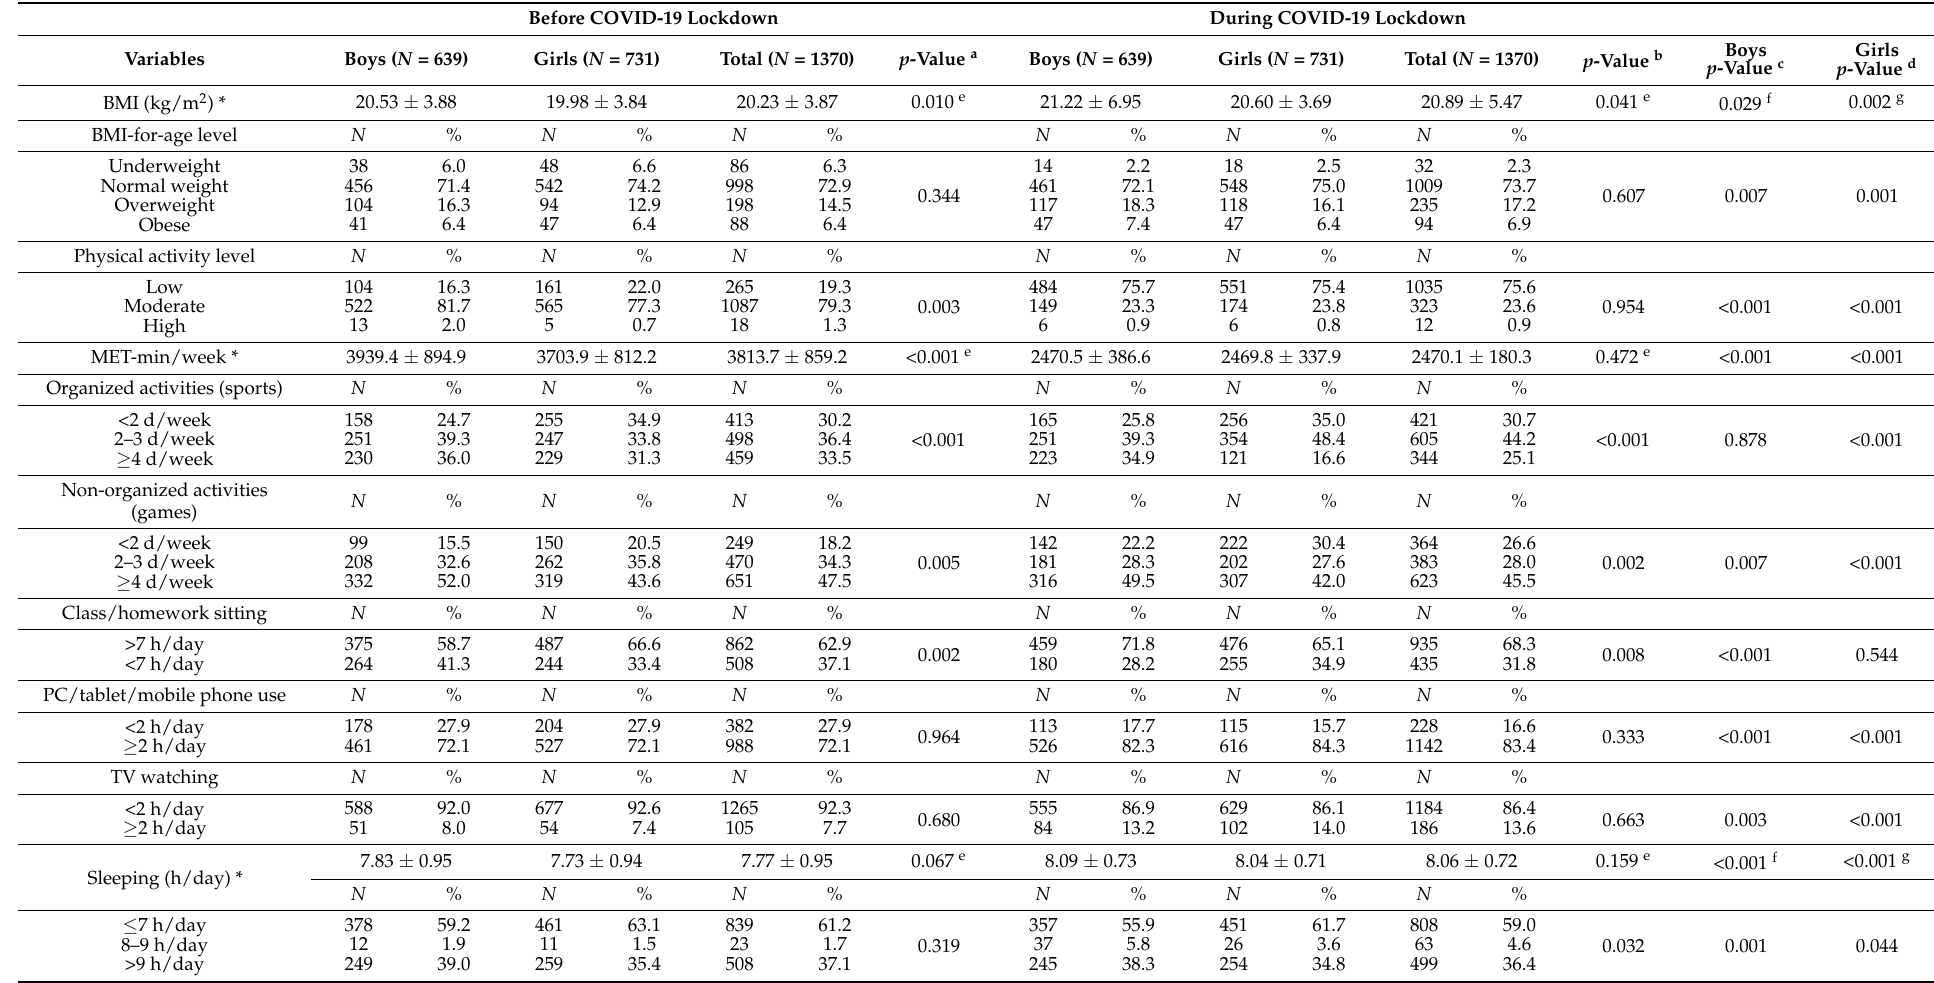
Table 1. Characteristics and lifestyle habits of participants according to gender before and during COVID-19